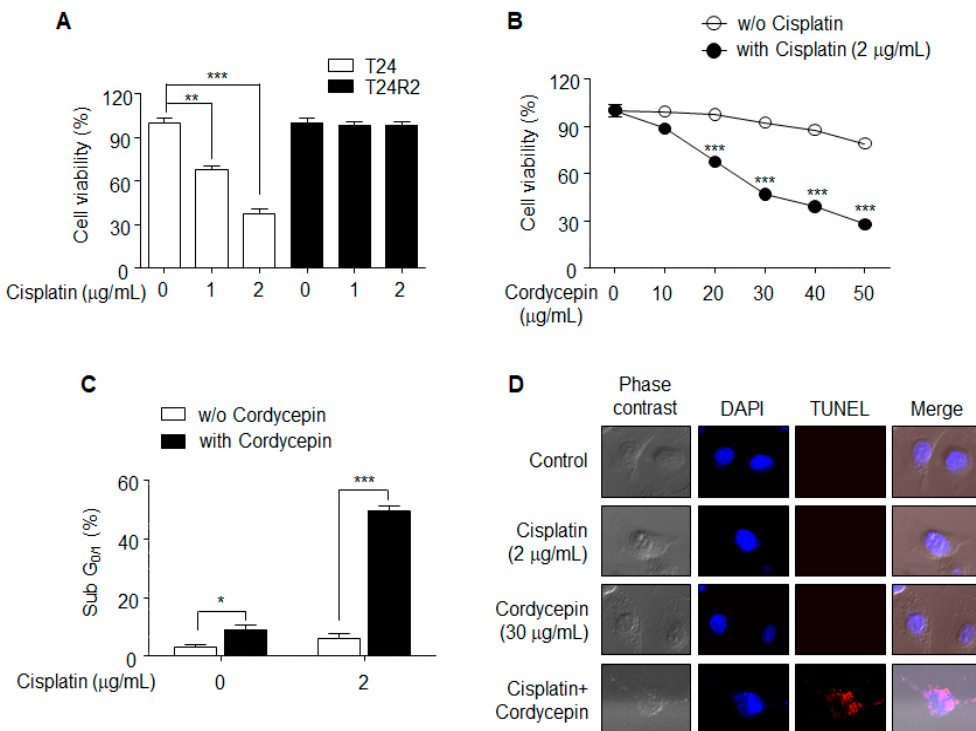
Figure 1. Effects of cordycepin treatment on T24R2 cell sensitivity to cisplatin. ( A ) T24 and T24R2 cells were incubated for 24 h with different concentrations of cisplatin (0, 1, or 2 μ g/mL). Cell viability was determined by MTT (3 ‐ [4,5 ‐ dimethylthiazole ‐ 2 ‐ yl] ‐ 2,5 ‐ diphenyltetrazolium bromide) assay. ( B , C ) Cordycepin ‐ mediated resensitization of T24R2 cells to cisplatin. T24R2 cells were treated with cordycepin in the presence or absence of cisplatin, and their viability was measured using the MTT assay ( B ). Bonferroni post hoc correction for multiple comparisons was performed to compare means by row (the effect of cordycepin was compared in matched group in the presence or absence of cisplatin). Determination of sub ‐ G 1/0 was accomplished using propidium iodide staining. (C, D ) Apoptosis of T24R2 cells induced by combination treatment with 30 μ g/mL cordycepin and 2 μ g/mL cisplatin was analyzed by TUNEL (terminal deoxynucleotidyl transferase dUTP nick end labeling) and DAPI (4 ′ ,6 ‐ diamidino ‐ 2 ‐ phenylindole) staining. The results are representative of at least two independent experiments. * p < 0.05; ** p < 0.01; *** p < 0.001 by t ‐ test.